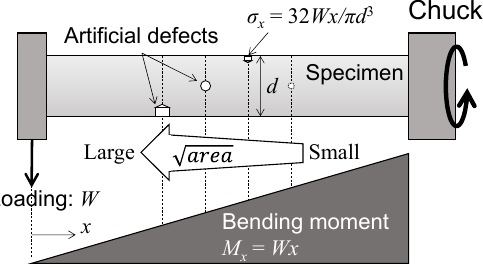
Figure 3. Schematic illustration of moment distribution at each artificial defect.